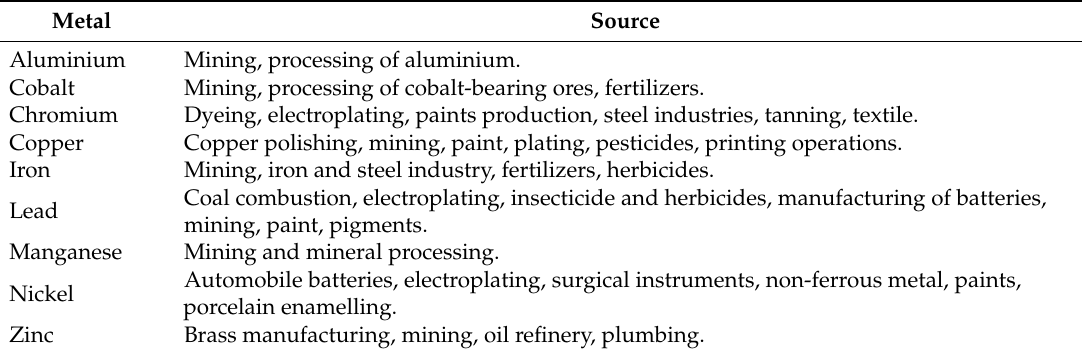
Table 1. Sources of heavy